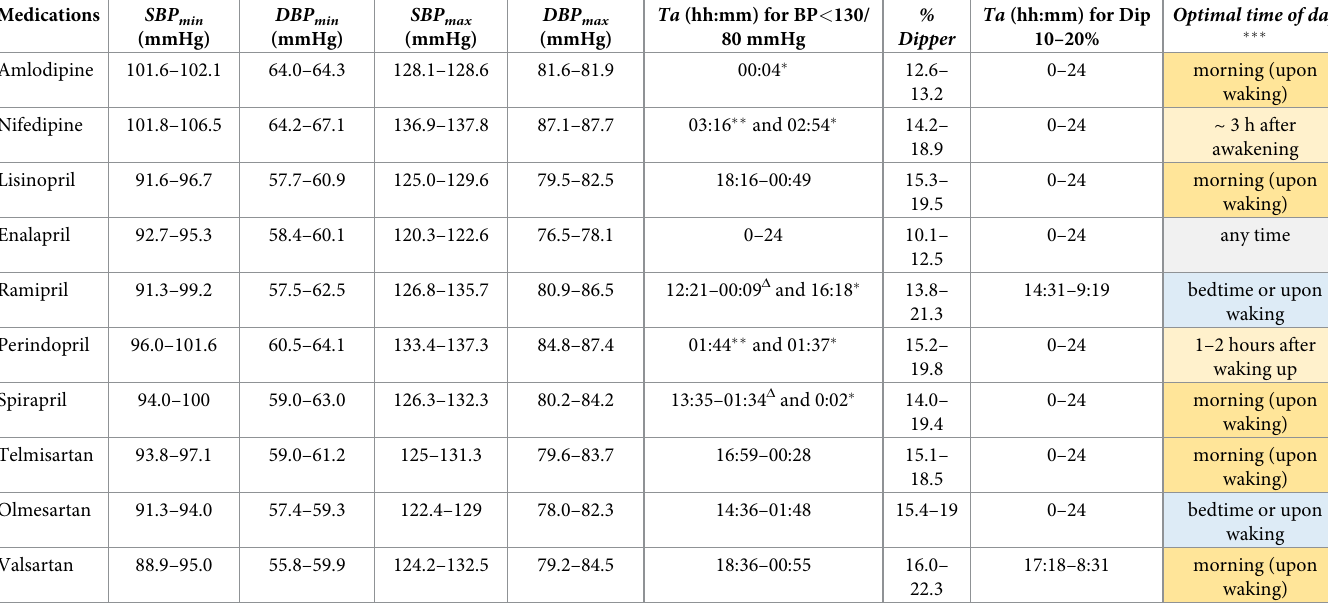
� Ta after awakening in which the minimum DBP �� Ta after awakening in which the minimum SBP Δ Ta after awakening range in which SBP predicted values are less than 130 mmHg.